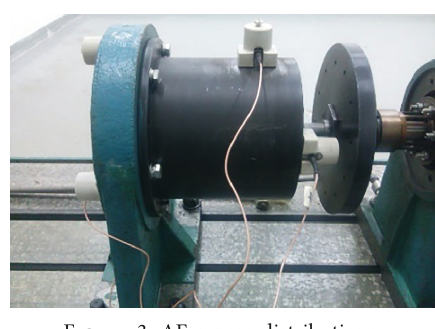
Figure 3: AE sensor distributions.